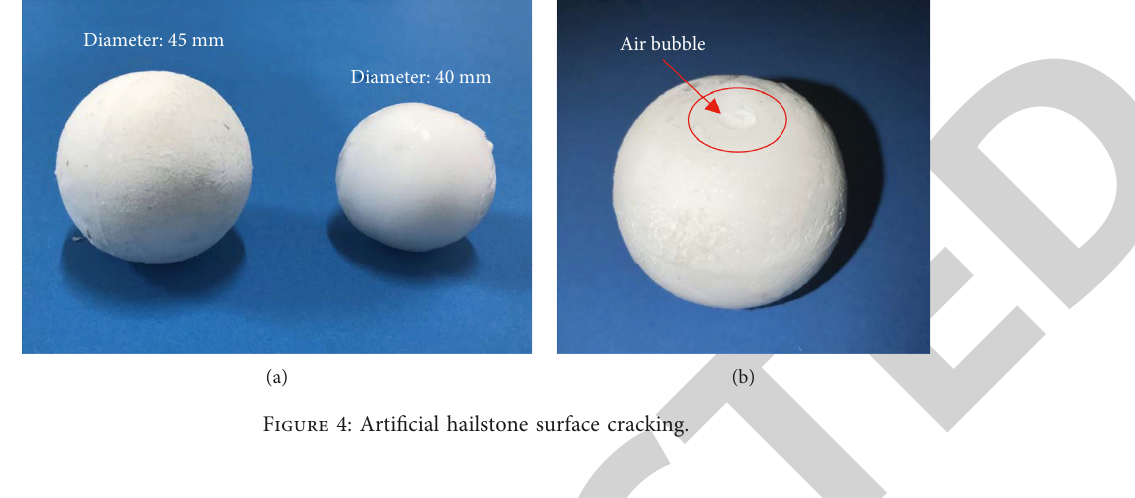
Figure 4: Artificial hailstone surface cracking.